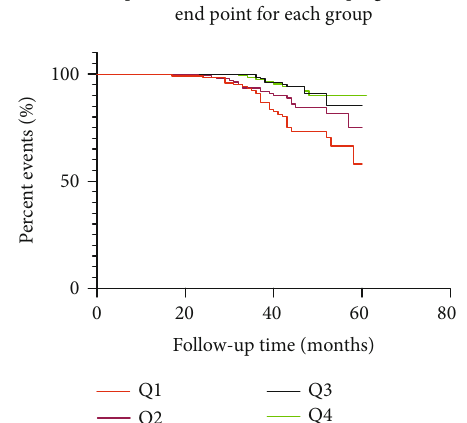
Figure 3: Kaplan-Meier survival curves by TBIL strati fi cation ( n = 540 ). Patients were categorized into four groups: Q1 ( N = 121 ), Q2 ( N = 140 ), Q3 ( N = 151 ), and Q4 ( N = 128